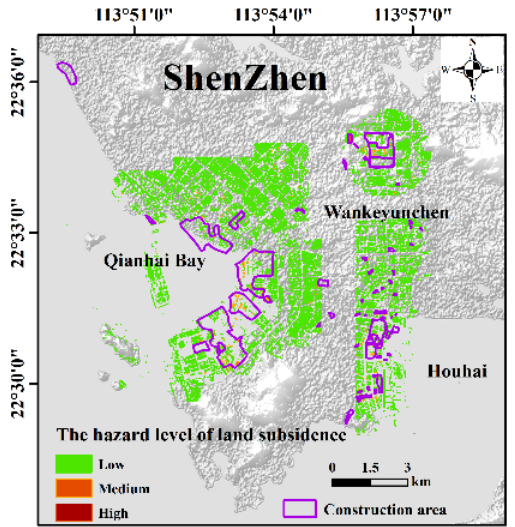
Figure 10. Hazard assessment of building in three main subsidence